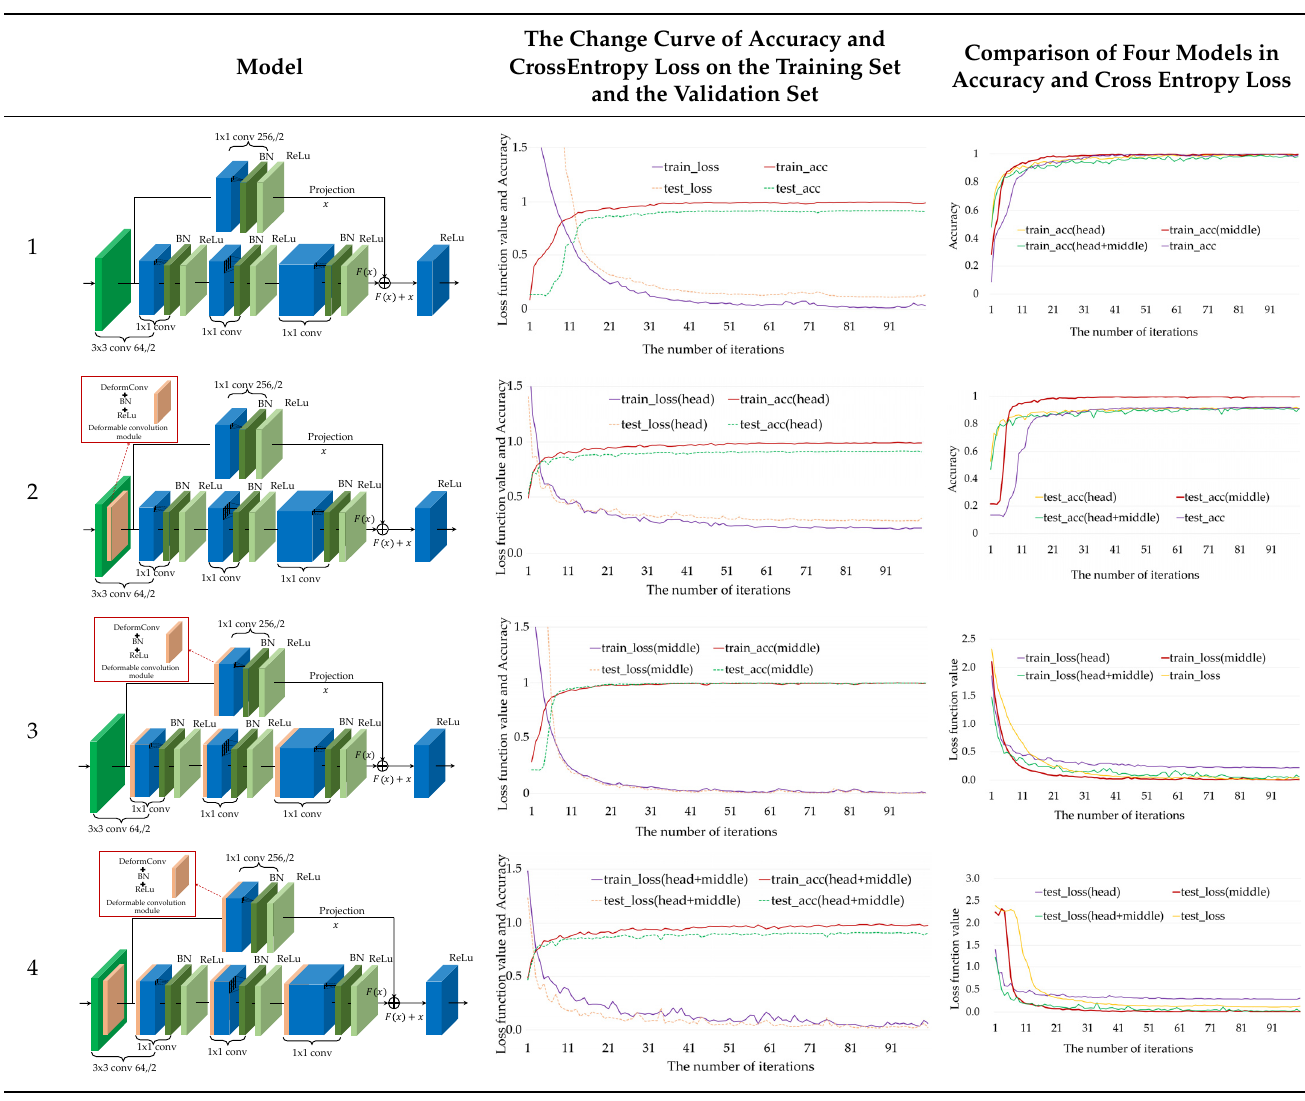
Table 2. Four ResNet models with deformable convolution at different locations.